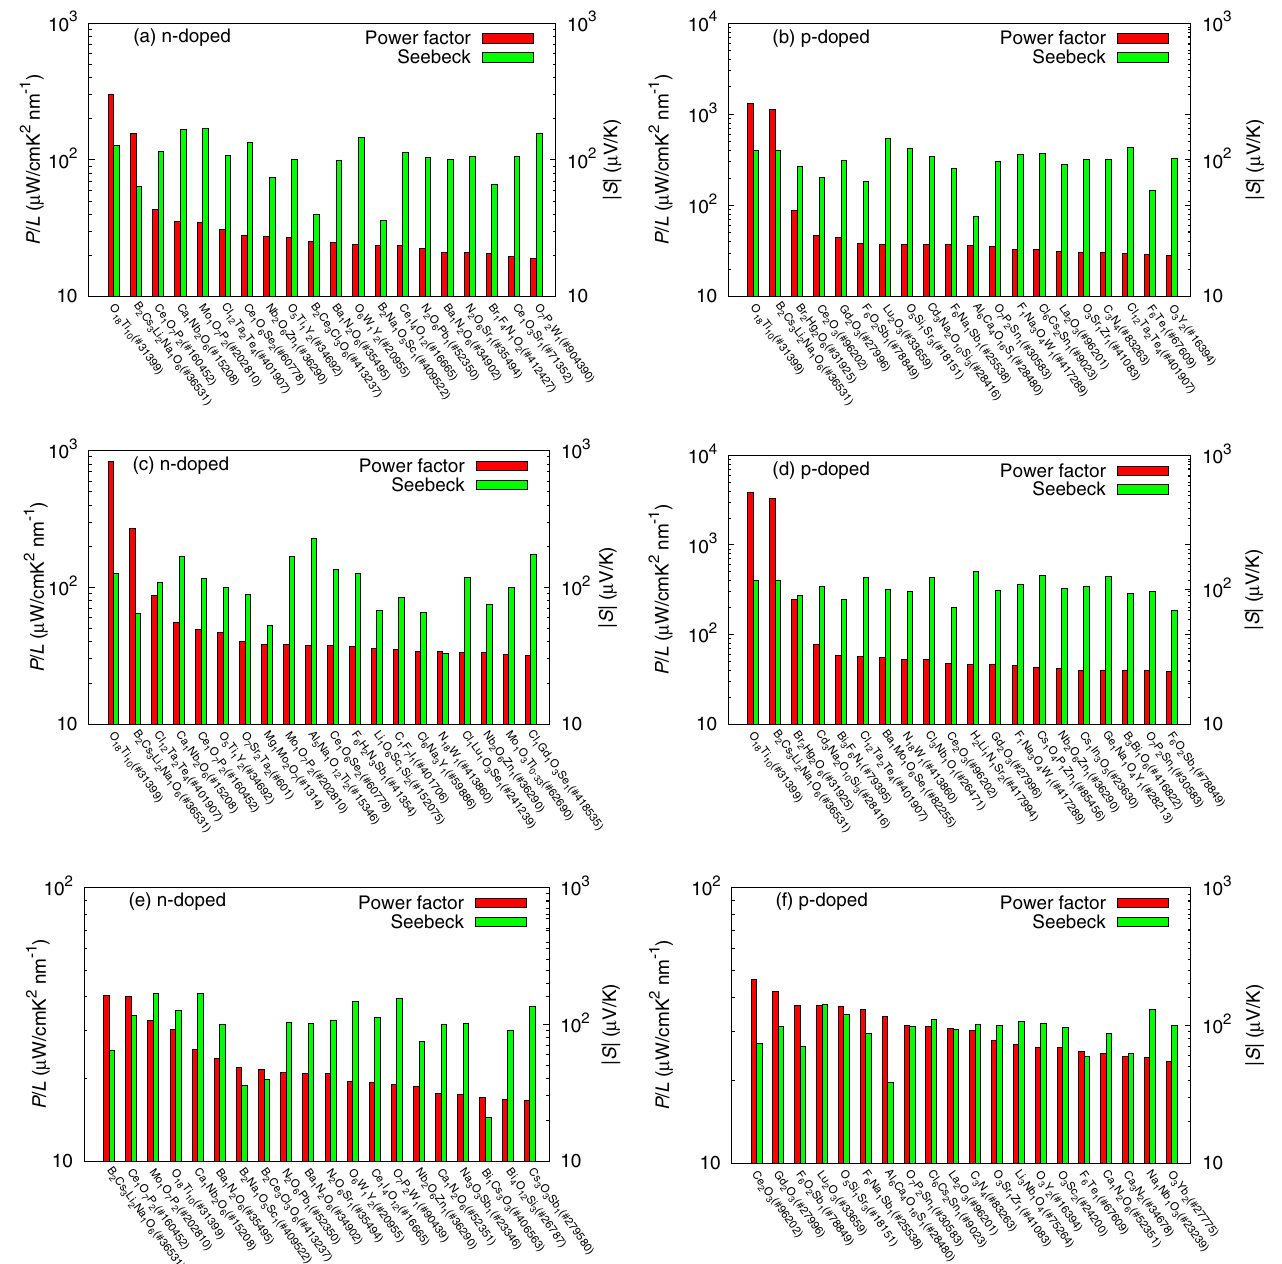
FIG. 1. Materials selection. The best 20 compounds for (a) n- and (b) p-doped average normalized power factor h P i =L by grain size L ; (c) n- and (d) p-doped principal-axis maximum P corresponding Seebeck coefficients are also